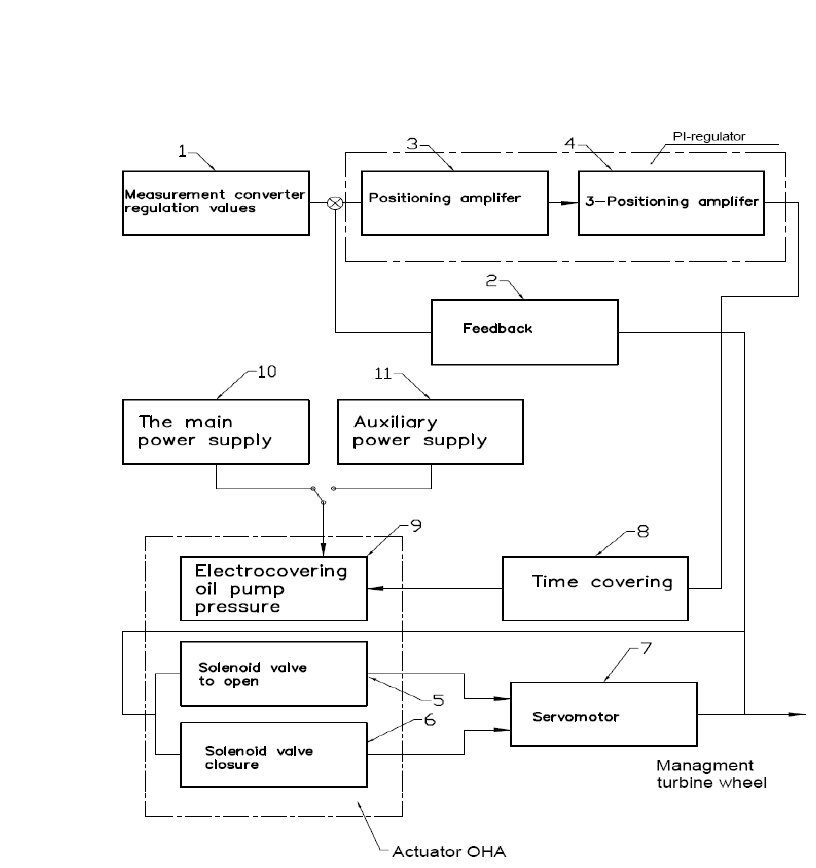
Figure 6 – Electro hydraulic controller type EHR-80 for MHPs Рисунок 6 – Электрогидравлический регулятор ЭГР -80 для Мини ГЭС Слика 6 – Електрохидраулични регулатор тип EHR-80 за